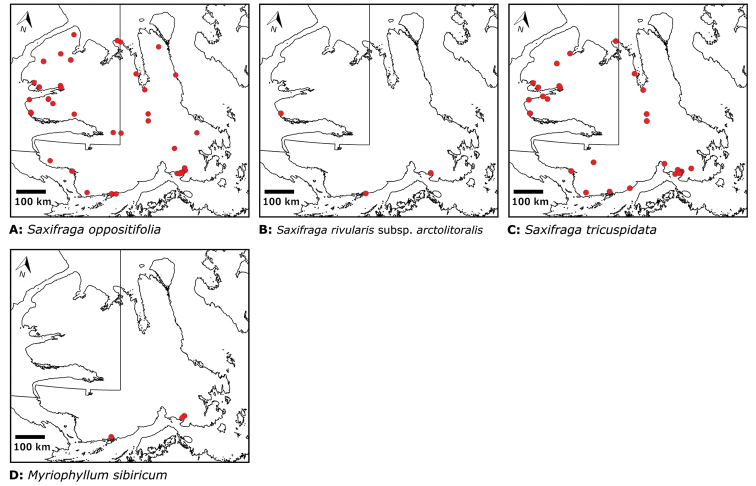
Species distribution maps. Saxifragaceae: ASaxifraga
oppositifoliaBSaxifraga
rivularis
subsp.
arctolitoralisCSaxifraga
tricuspidata. Haloragaceae: DMyriophyllum
sibiricum.